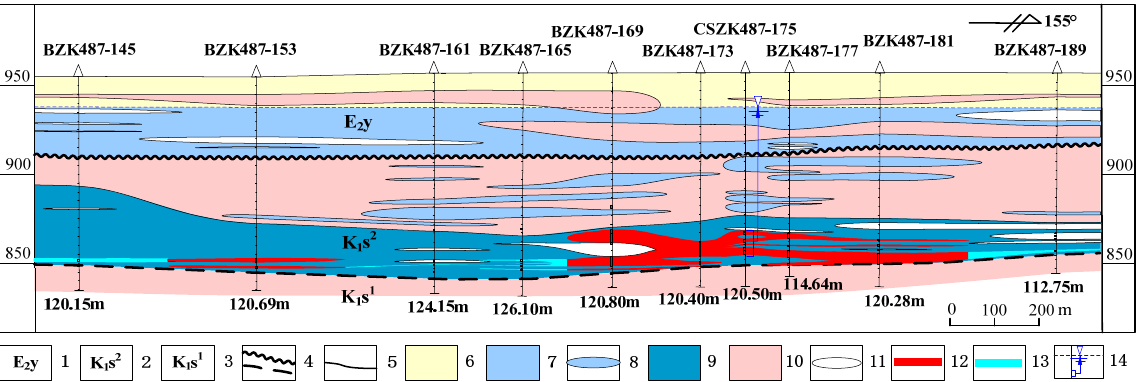
Figure 2. The transversal hydrogeologic profile at an in situ leaching uranium mine in Inner Mon ‐ golia. Note: 1 ‐ Yierdingmanha group; 2 ‐ The upper member of Saihan group; 3 ‐ The lower member